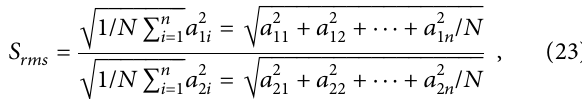
table tests of a frame structure are conducted under diferent sinusoidal and seismic excitations with and without an NSBD. Te results reveal that the NSBD can efectively